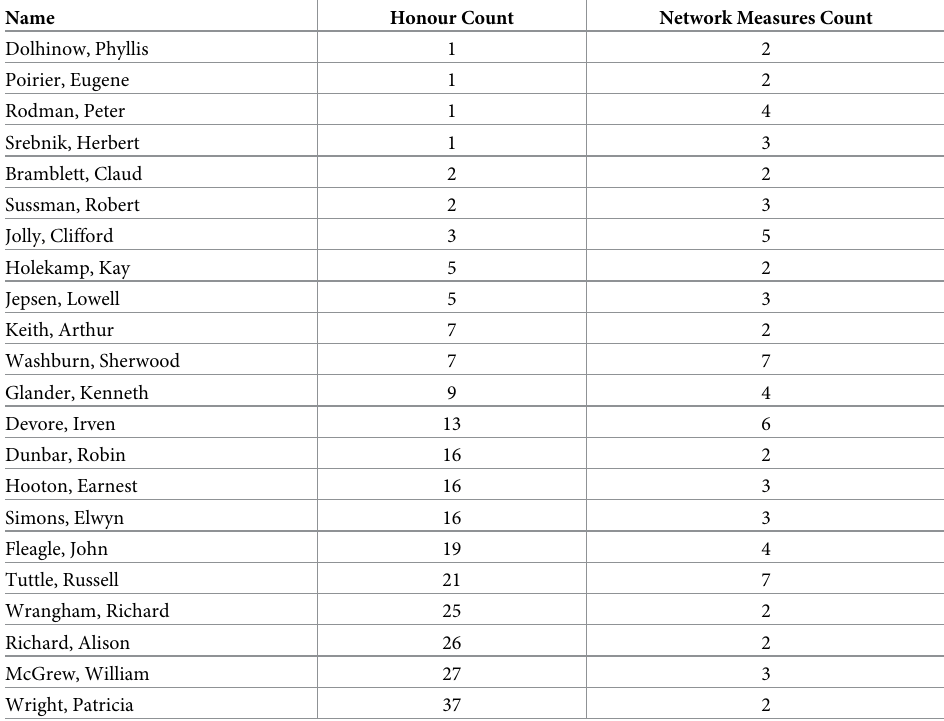
Table 6. List of academics showing correlation between number of real-world honours received (Honour Count) and significant position in academic network analysis (Top 20 nodes by network centrality measure). Name Honour Count Network Measures